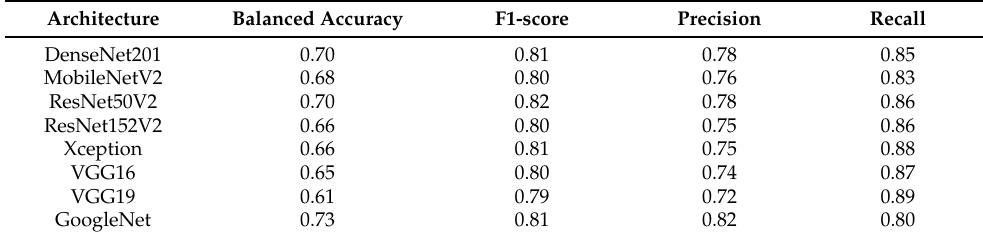
Table 4. Performance results for all architectures based on various